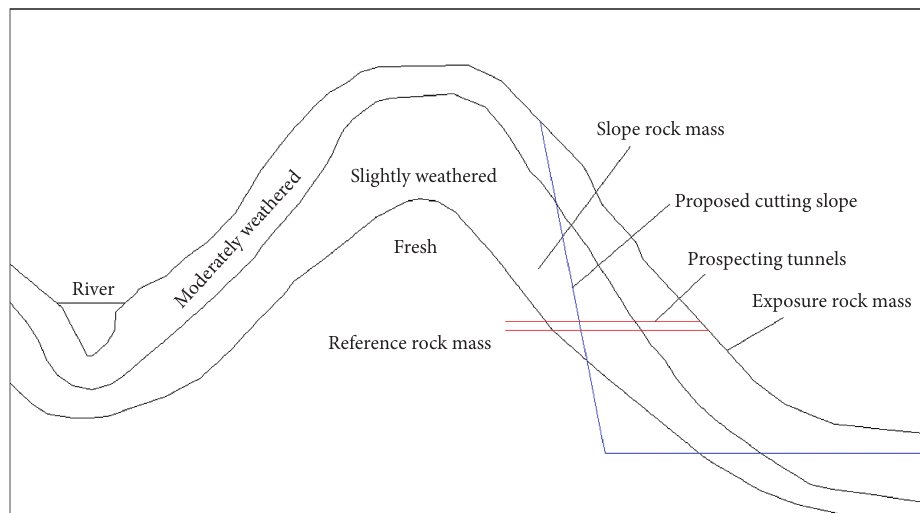
Figure 4: Sketch of exposures in rock masses of various degrees of weathering and different types of excavation indicating the concept of the reference rock mass.